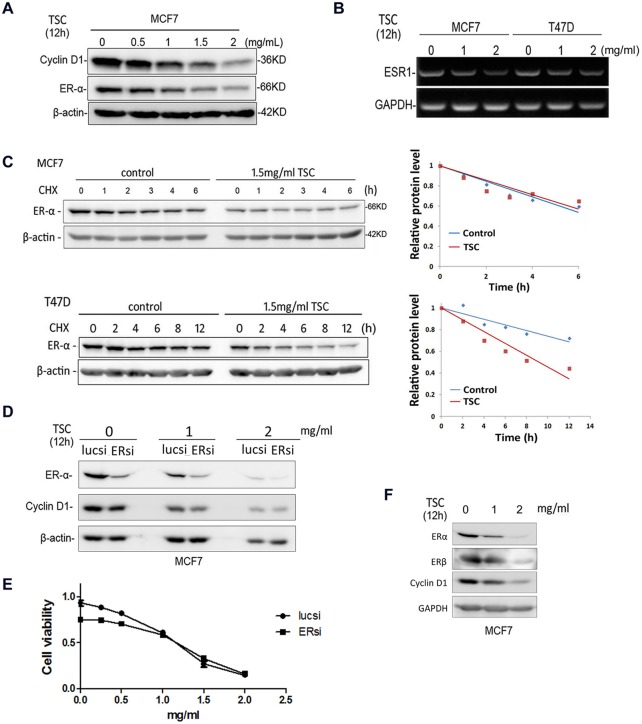
TSC inhibits the expression of ERα and Cyclin D1.A. TSC down-regulated the protein expression of ERα and Cyclin D1 in MCF7 in a dosage dependent manner. MCF7 cells were treated with different concentrations of TSC for 12 h. The protein expression levels of ERα and Cyclin D1 were examined using WB. B. The mRNA expression levels of ESR1 are decreased by TSC in a dosage dependent manner in both MCF7 and T47D cell lines, as measured by RT-PCR. C. TSC promoted the protein degradation of ERα in T47D but not in MCF7, as detected by the cycloheximide (CHX) chase assay. Quantitative results are show on the right. D. Knockdown of ERα decreased the expression of Cyclin D1 in MCF7 and partially abrogated the effect of TSC on Cyclin D1 expression down-regulation. E. Knockdown of ERα decreased the cell viability of MCF7 and partially abrogated the effect of TSC on inhibiting MCF7. F. TSC down-regulated the protein expression of ERβ in MCF7. MCF7 cells were treated with different concentrations of TSC for 12 h. The protein expression levels of ERα, ERβ, and Cyclin D1 were examined by WB.